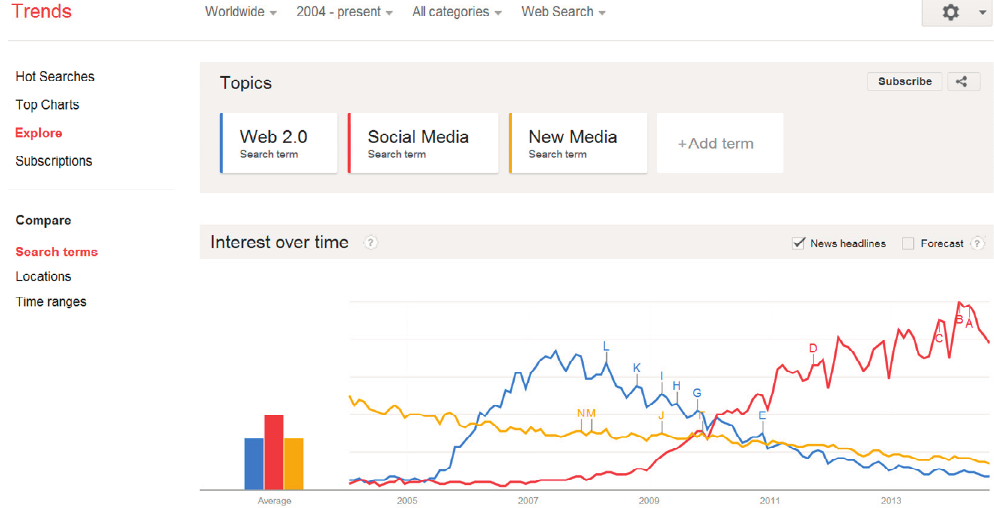
Figure 1. Google Trends [87] search for the terms Web 2.0 (blue), social media (red) and new media (yellow). It shows searches for social media begin rising later than Web 2.0, eventually overtaking it around 2010, while the usage of new media originates before Web 2.0, and has progressively